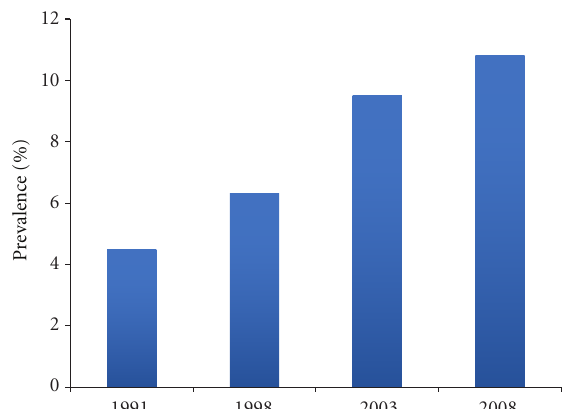
Figure 1: Prevalence of atopic dermatitis in Greek schoolchildren, 1991–2008